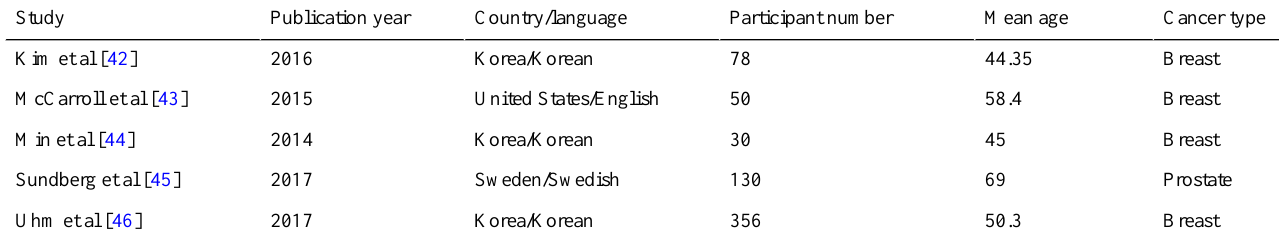
Table 1. General characteristics of included studies